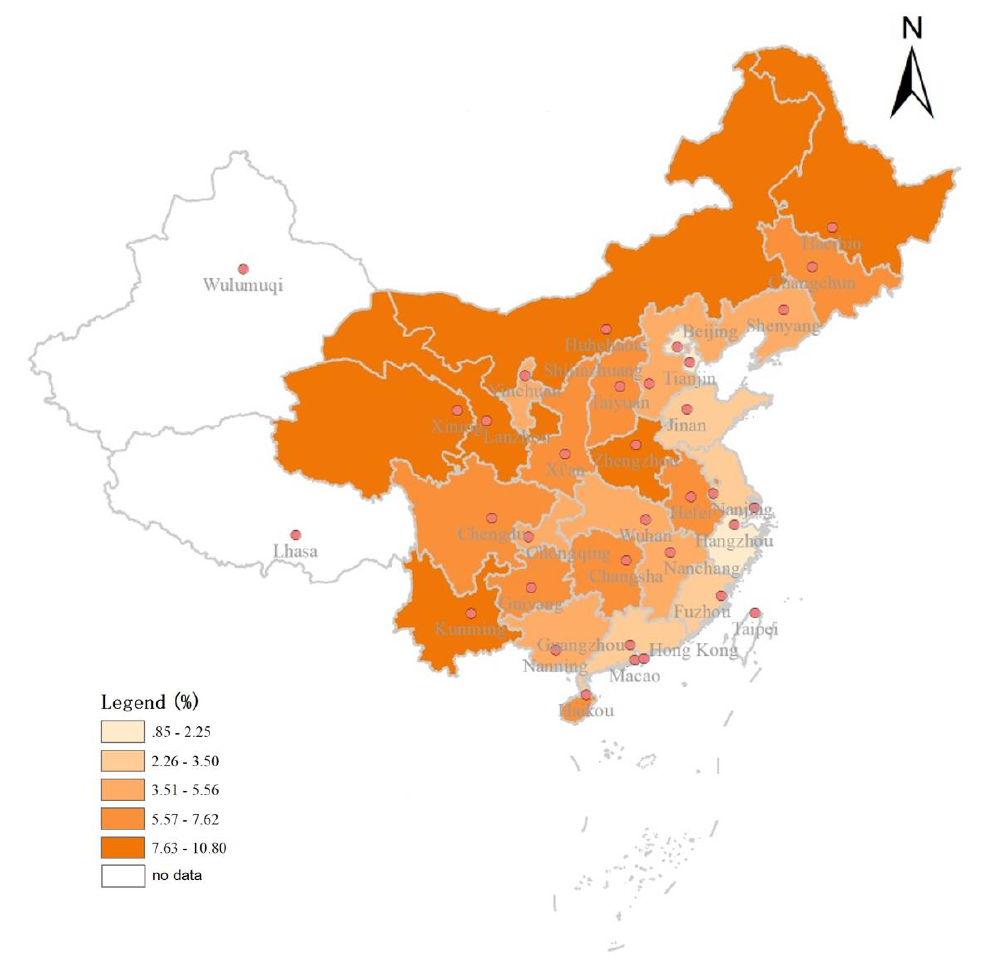
Figure 1. Geographical Distribution of Medical Debt Incidence in 2015. Table 2. Catastrophic Health Expenditure Incidence and Medical Debt among Poverty and Non-Poverty